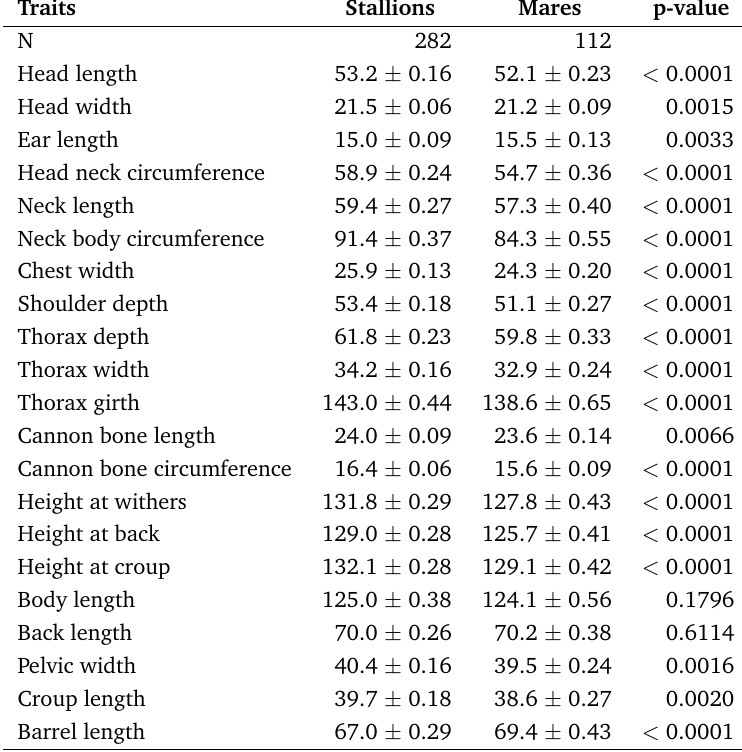
Table 3. Least-square means ± standard errors of quantitative body measurements (cm) of the horse populations by sex.